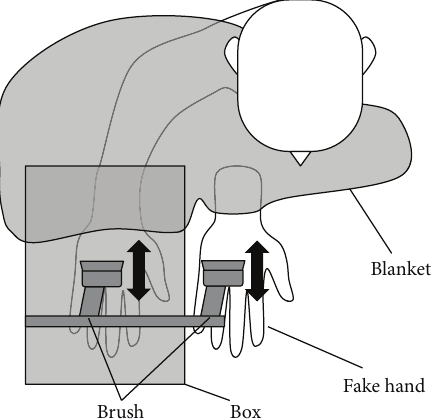
Figure 1: The setup used to induce RHI by automated brush stroking. The participant’s hand and the fake hand were veiled by a box and both of hands wore cotton gloves which reduce the difference of shape and texture. Moreover a blanket covered his or her arm so that the participant watches only the fake